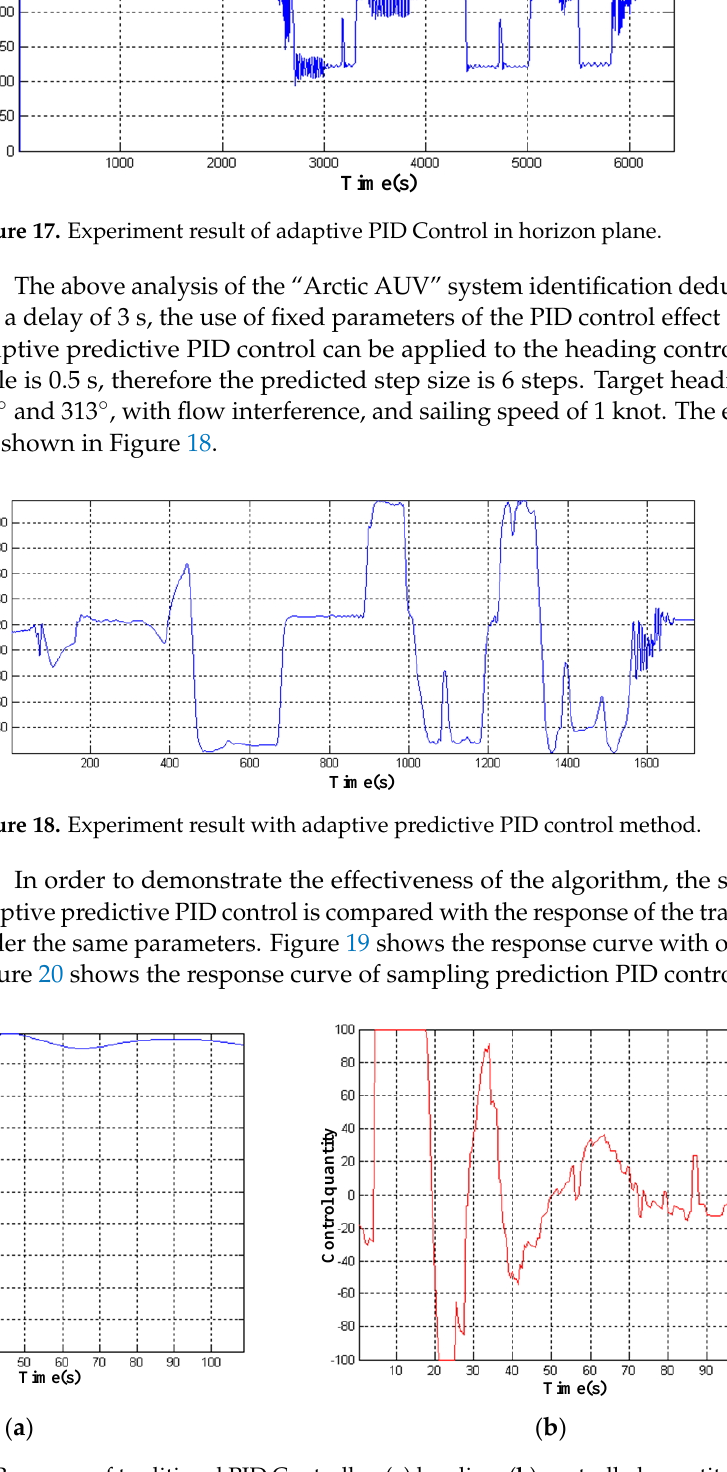
Figure 17. Experiment result of adaptive PID Control in horizon plane.